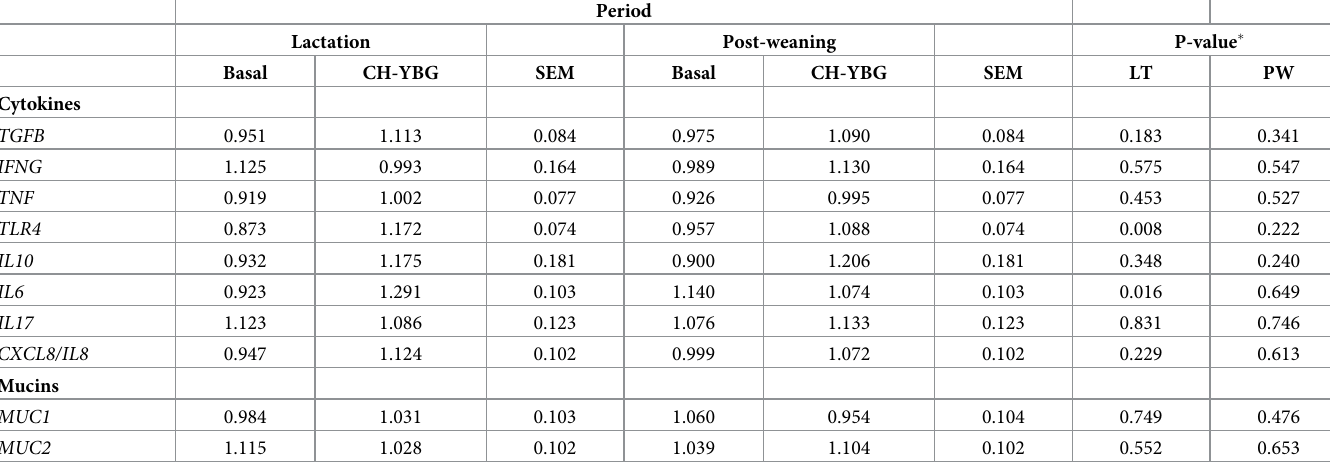
Table 14. Effect of supplementation of CH-YBG during gestation/lactation and/or post-weaning on the expression cytokines and mucins in the colon. (least-square mean values with their standard error of